Question: Write a single sentence explaining what this figure depicts.
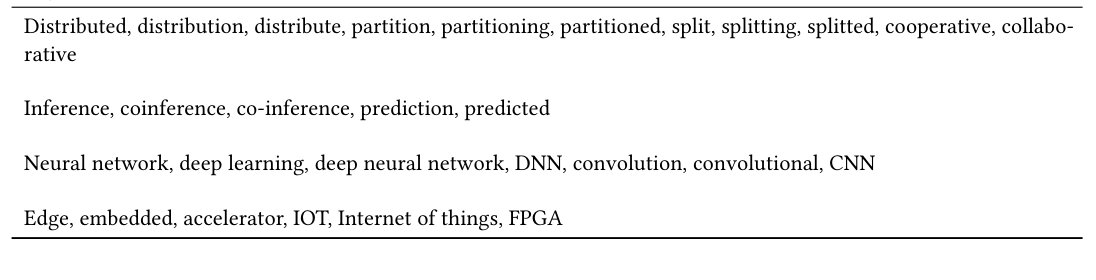
Answer: Systematic review process